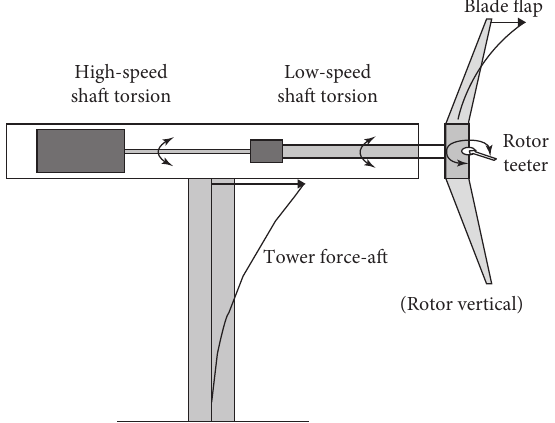
Figure 2: Blade flap and tower fore-aft degrees of